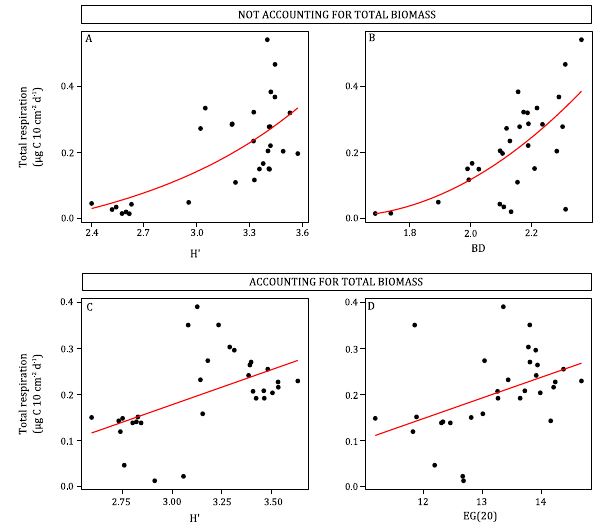
Fig. 5. Relationship between diversity and total respiration in ne- matode communities. (A) and (B) show the marginal regressions of diversity against respiration (not accounting for total nematode biomass), while (C) and (D) show the partial regressions of diver- sity against respiration (accounting for total nematode biomass). H 0 : Shannon–Wiener diversity, BD: biomass diversity, EG(20): ex- pected genus richness for a sample of 20